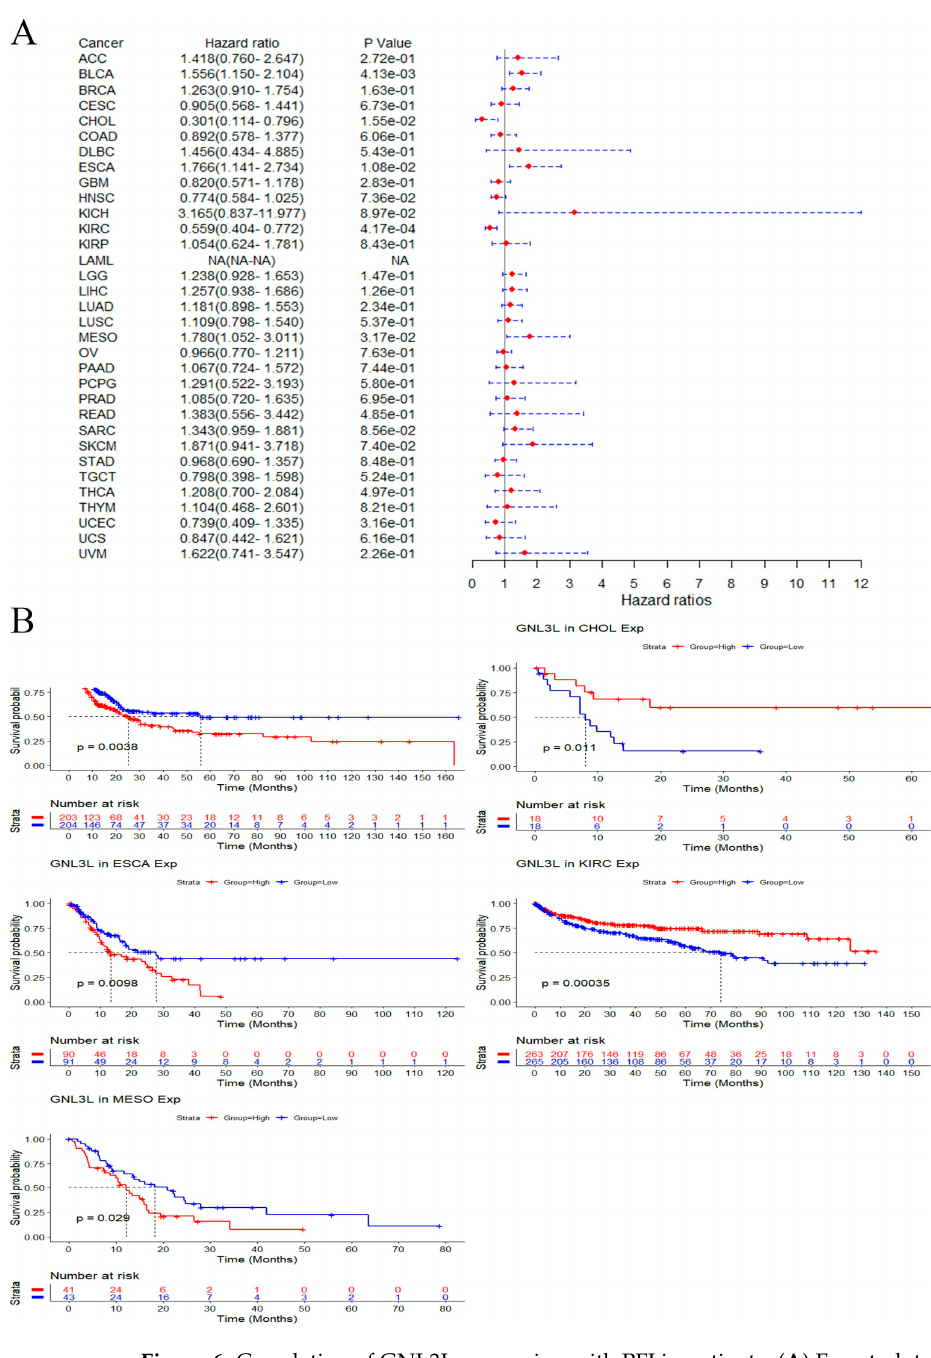
Figure 6. Correlation of GNL3L expression with PFI in patients. ( A ) Forest plot of PFI risk ratios for GNL3L in 33 cancers. ( B ) Kaplan–Meier PFI curves for patients in BLCA, CHOL, ESCA, KIRC, and MESO malignancies stratified by GNL3L expression levels.